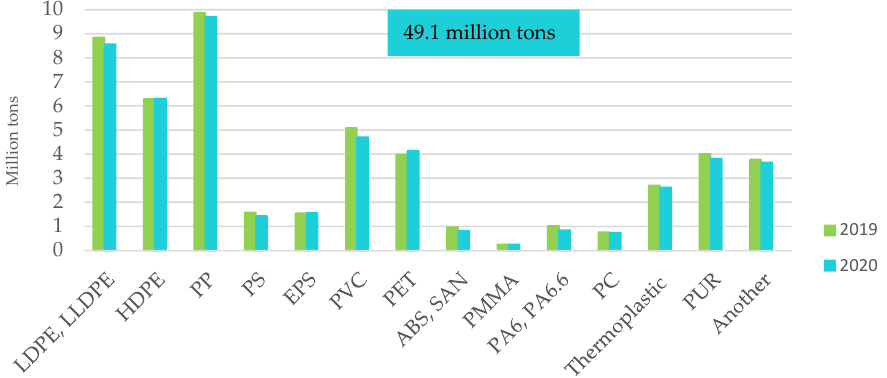
Figure 7. Demand for plastics in the EU27 + 3 by type of polymer in 2020. Made based on [3].